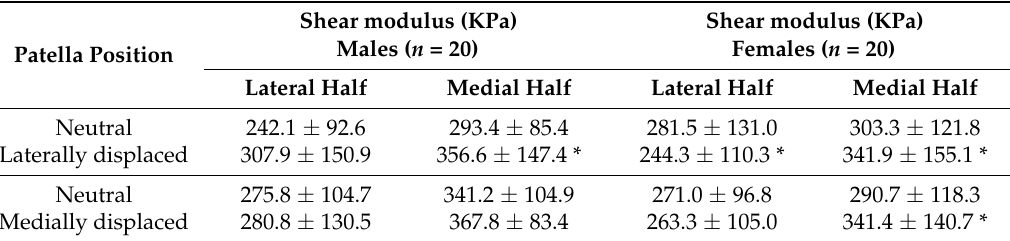
Table 3. Shear modulus of patellar tendon at its resting and displaced positions.